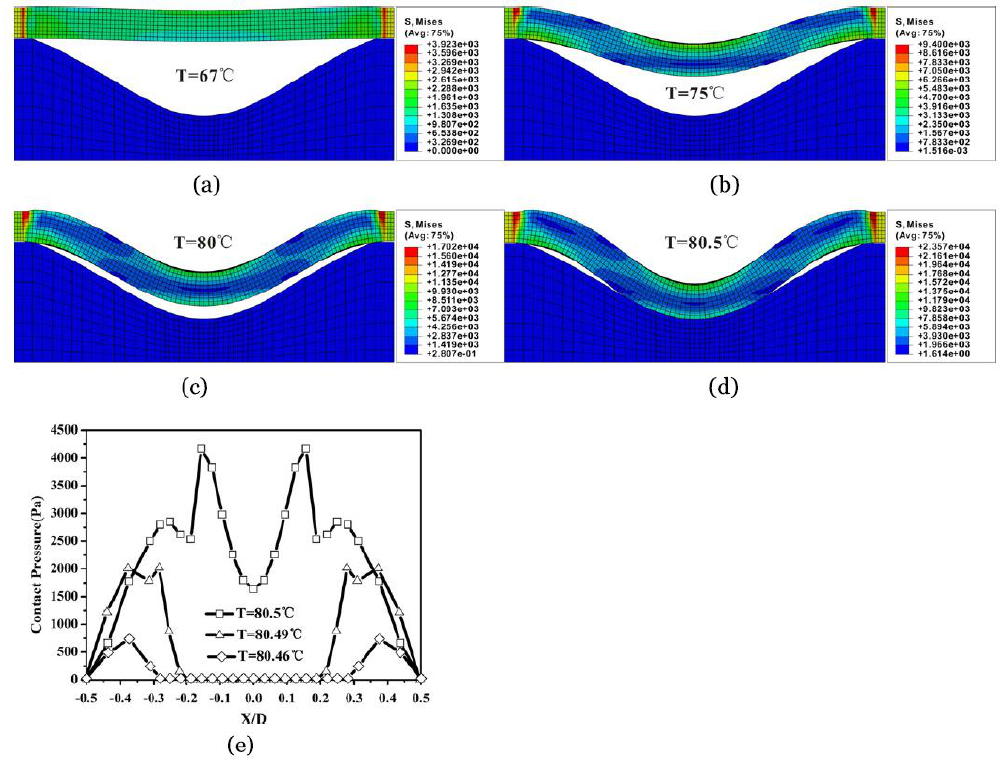
Figure 4. ( a – d ), show the deformation, distribution of stress, and contact pressure of the LCE microvalve, at various temperatures. Note that the color intensity represents the intensity of the local stress distribution. ( e ) illustrates both the contact region and contact pressure between the LCE valve and surrounding silicon wall. Note that the temperature is close to phase transition temperature [25]. Here, X is the distance measured from the central point of the contact and D is the length of the contact area of the LCE beam [25] (Reprinted with permission from [25]).